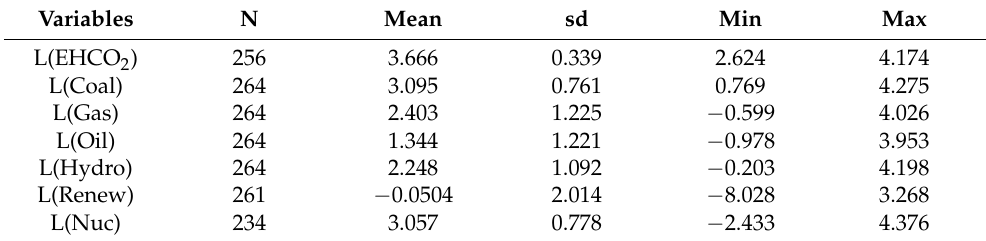
Table 2. Synopsis of Descriptive